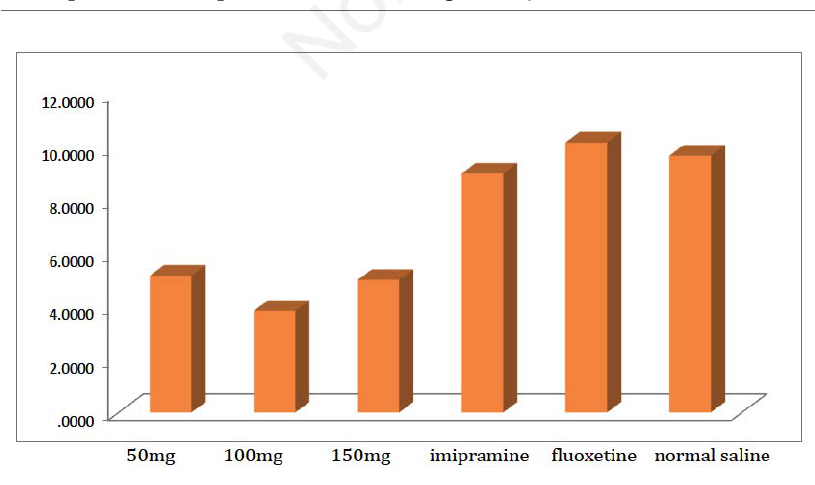
Figure 3. Effect of aqueous extract of plant (50, 100, 150 mg/kg) Lavandulifolia Stachys , imipramine, fluoxetine, normal saline on immobility Data represents the mean activity counts per 5 min. Comparisons were made using one-way ANOVA.